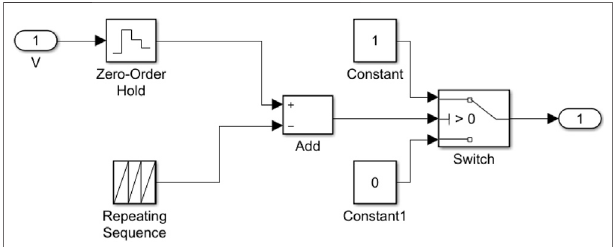
FIGURE 6 | PWM wave generation